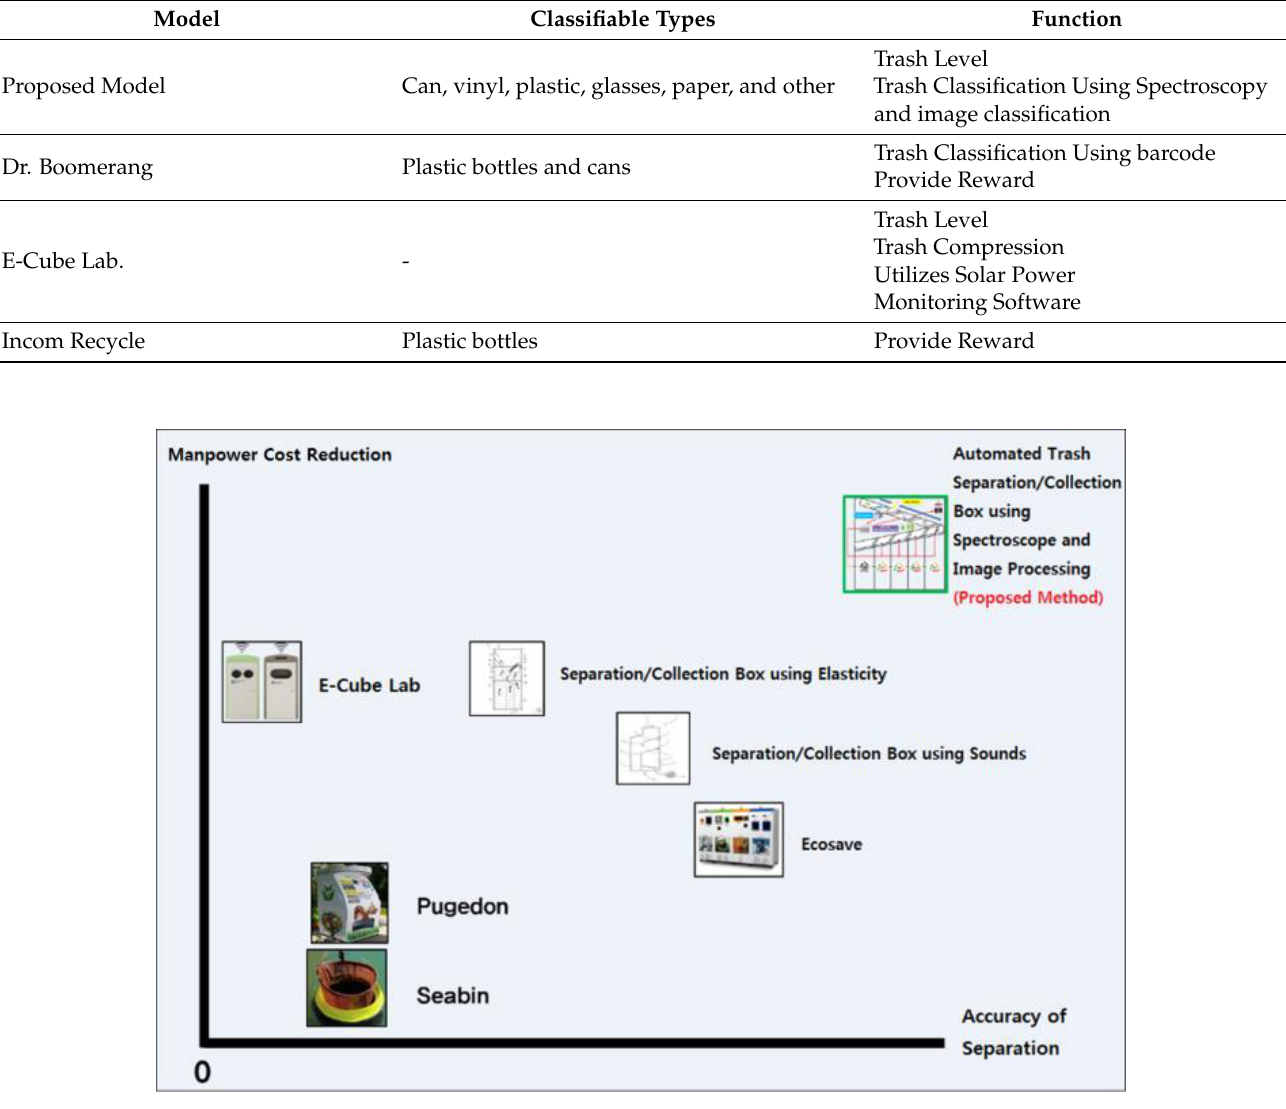
Figure 11. Adequacy of each design.